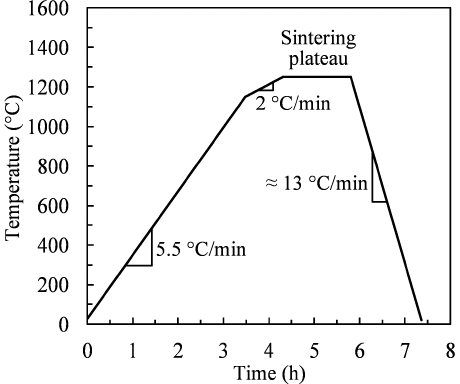
Figure 3. Sintering cycle under hydrogen atmosphere.